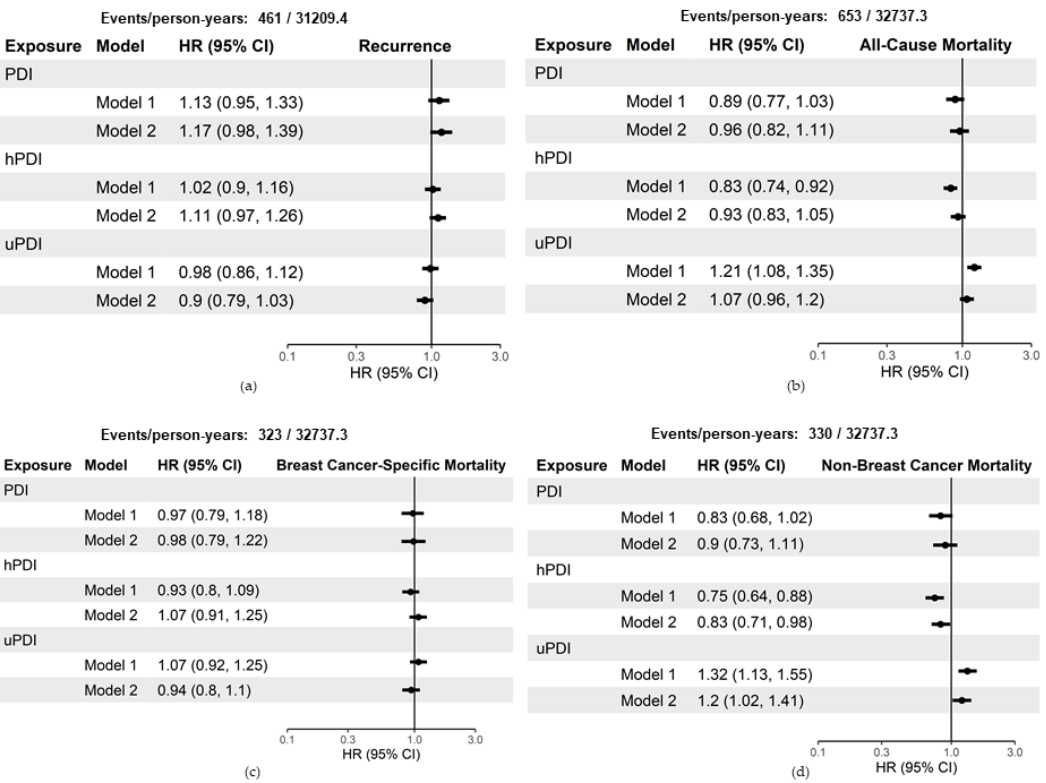
Figure 3. Hazard ratios and 95% confidence intervals for a 10-unit increase in time-dependent cumulative average plant- based indices with breast cancer recurrence and survival amongst 3646 breast cancer survivors, Pathways Study. Model 1 adjusted for the following covariates: age at diagnosis, total energy intake (kcal/d), and physical activity (moderate- vigorous MET-hours/week). Model 2 adjusted for the following covariates: Model 1 covariates, race/ethnicity, education, menopausal status, smoking status, and stratified by tumor stage and ER status: ( a ) includes estimates of the hazard of recurrence; ( b ) estimates of the hazard of all-cause mortality; ( c ) estimates of the hazard of breast-cancer-specific mortality; ( d ) estimates of the hazard of non-breast-cancer mortality. CI = confidence interval; HR = hazard ratio; PDI = plant-based diet index; hPDI = healthful plant-based diet index; uPDI = unhealthful plant-based diet index.